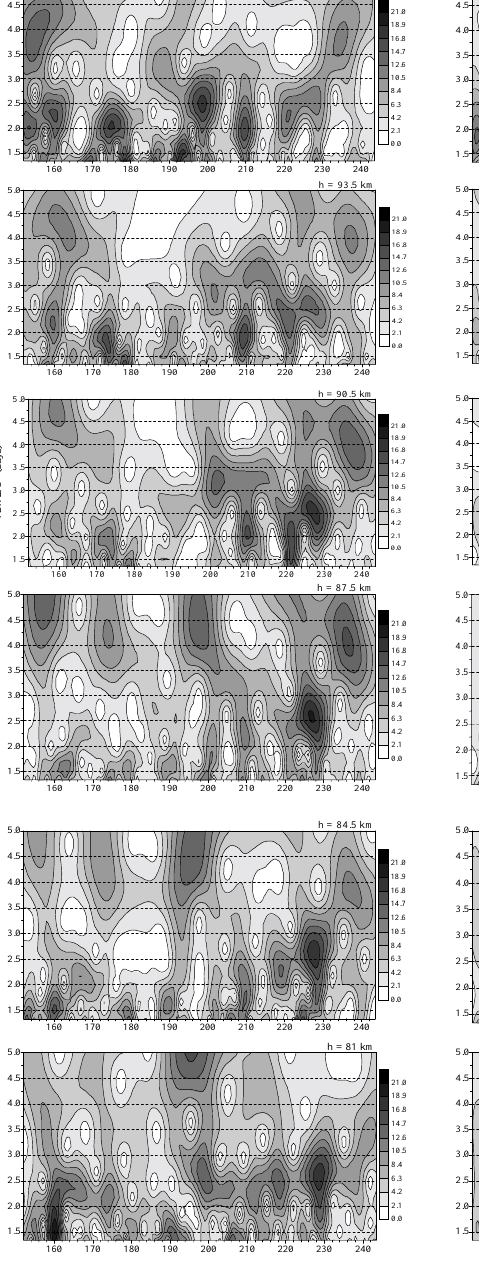
Although we use data collected only by meteor radars, there are some differences in the results obtained by different radars. First of all, the amplitudes of oscillations observed at Esrange are greater than the values obtained at Dixon and even of the same order as amplitudes of oscillations observed at middle-latitudes. Mitchell et al. (2002) noted similar dif- ferences, except for the tides. Fortunately, the phases and fre- quencies of oscillations usually are very consistent for data